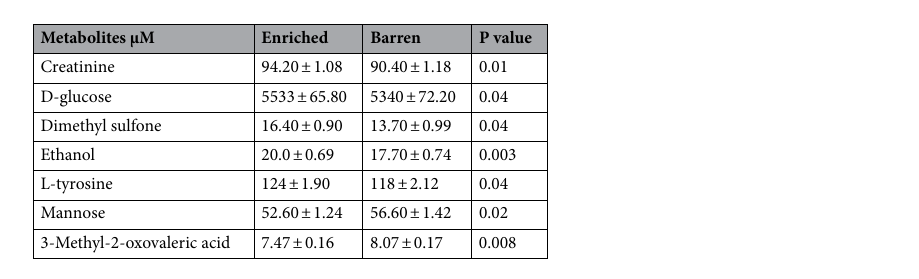
Table 2. Least squared means and SE of the concentration of significant serum metabolites in animals housed in enriched and barren environments at week 8, 9 and 22.